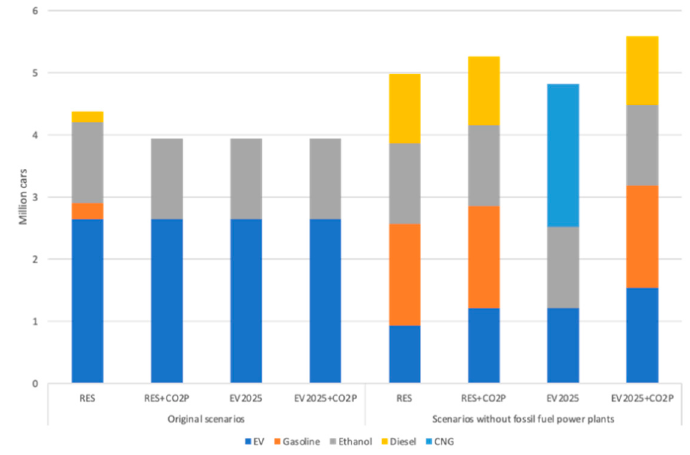
Figure 7. Light-duty vehicle fleet composition (million cars) in 2050—selected scenarios with and without fossil fuel power plants.